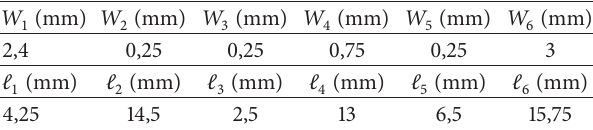
Figure 8: Cost function convergence curve. Table 3: Solution space for the (T-T) IMC and OMC elements.